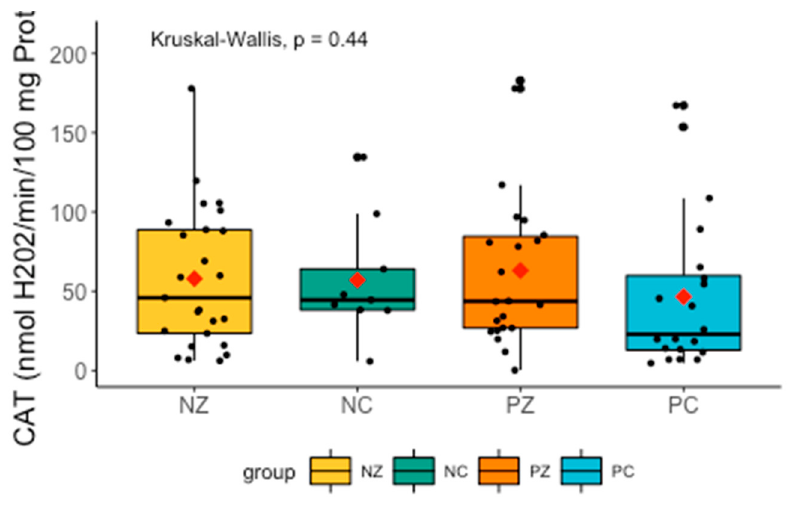
Figure 5. Activity of CAT in the examined groups. CAT, catalase activity; NZ, generally healthy patients without the BRCA1 mutation; NC, patients with breast cancer but without the BRCA1 mutation; PZ, generally healthy patients with the BRCA1 mutation; PC, patients with both breast cancer and the BRCA1 mutation.